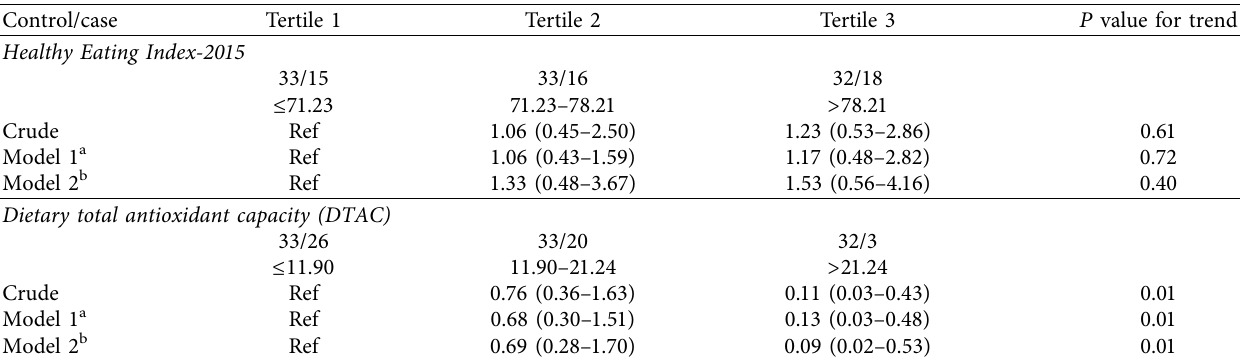
Table 3: Odds ratios and confidence intervals for the association between Healthy Eating Index-2015 and dietary total antioxidant capacity with